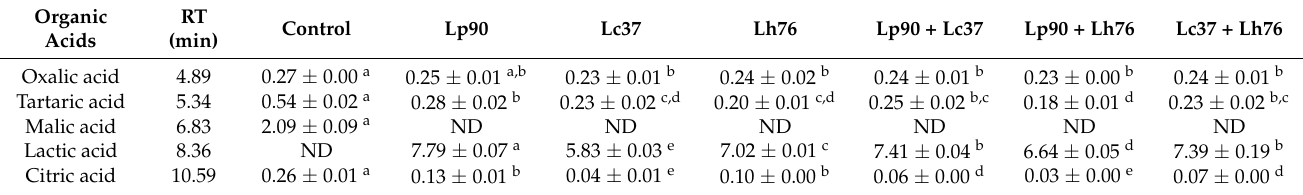
Table 1. Organic acids in pear juice fermented by monoculture and binary mixture of lactic acid bacteria (mg/mL).